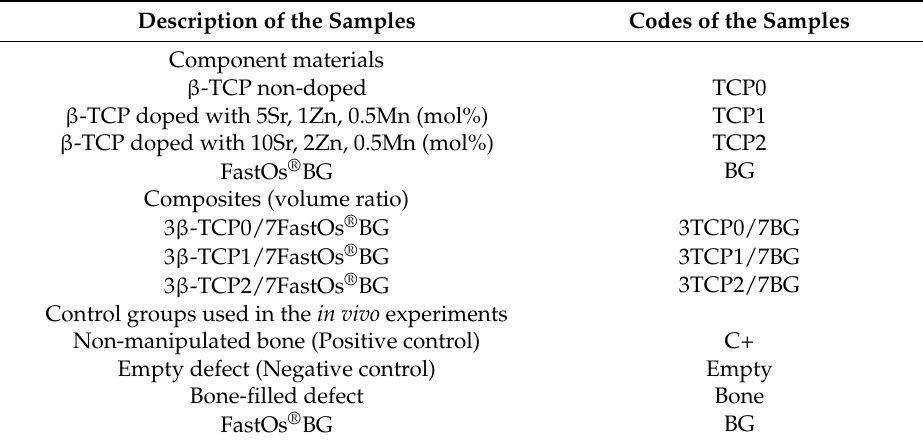
Table 2. Detailed description of the samples, and their respective